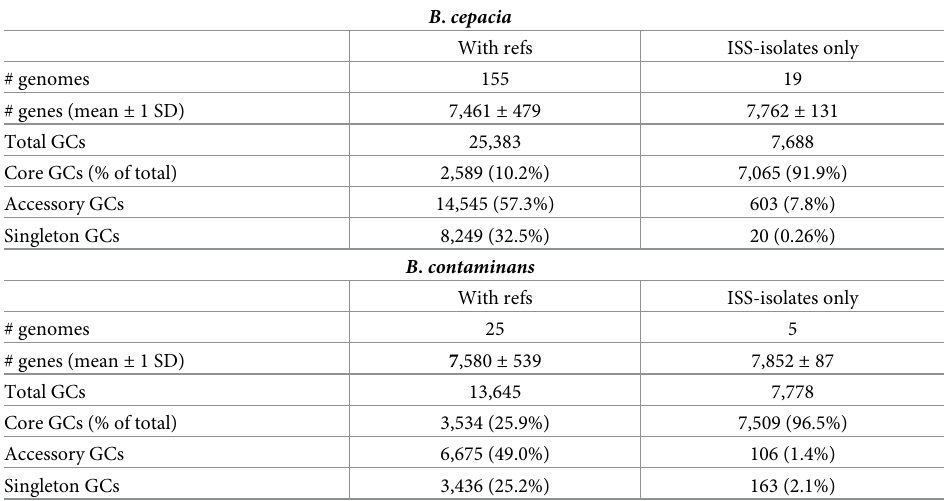
Table 1. Burkholderia pangenome overview of counts.